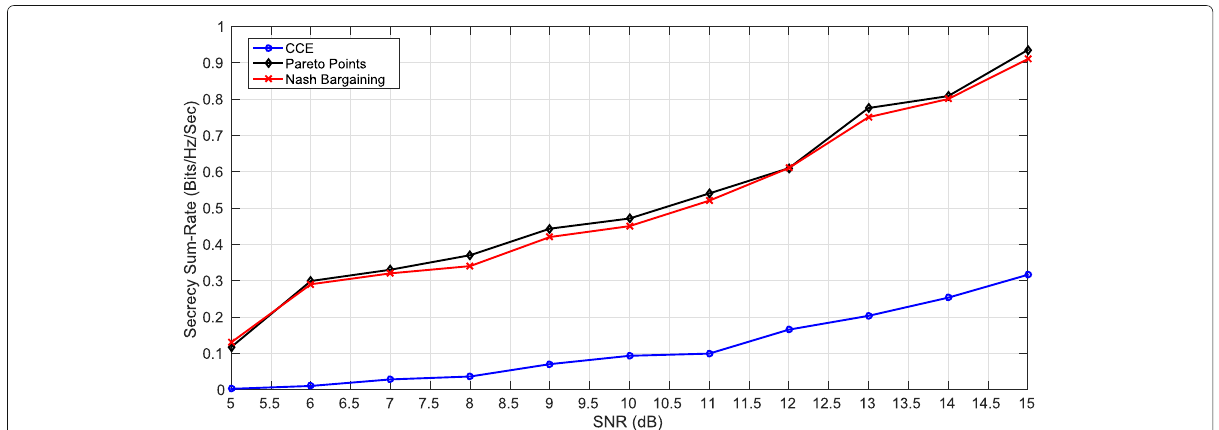
Fig. 8 Comparison of CCE, PP and NBS for F-MAC-WT, with no CSI of Eve (fixed transmission rate)